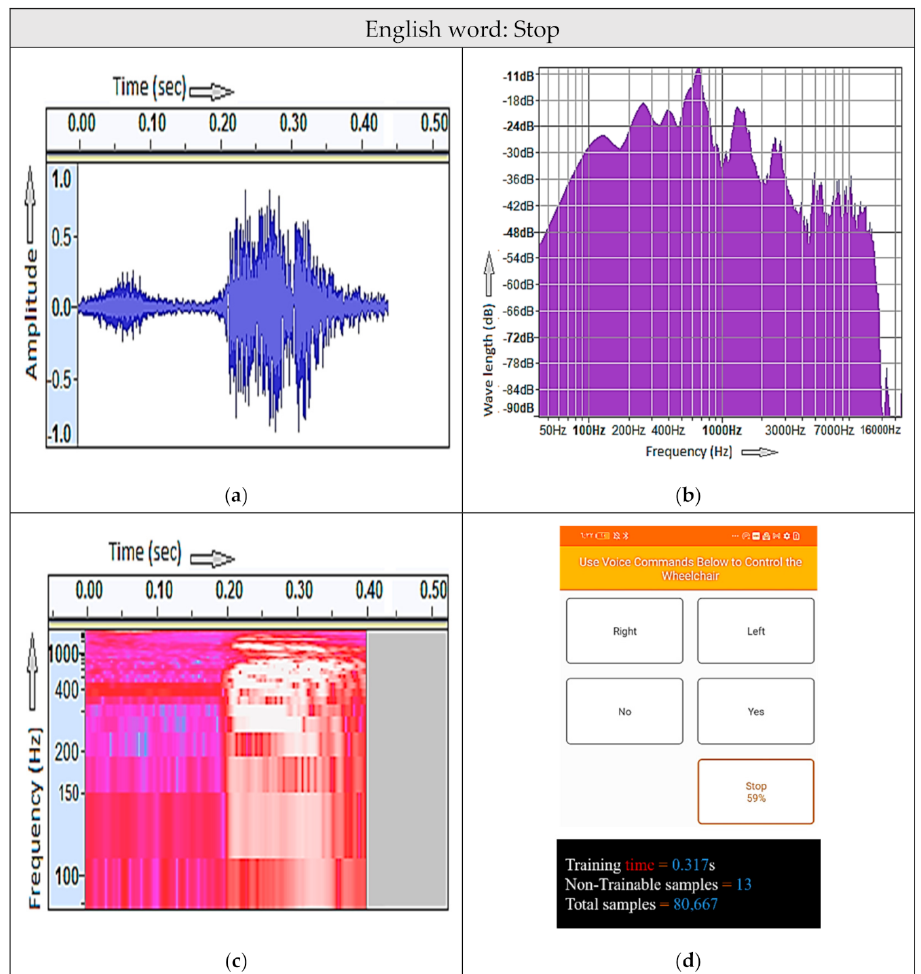
Figure 9. Recognition of the “Stop” voice command. ( a ) Audio shape; training time = 0.317 s; ( b ) long- term spectrum; frequency range = 21.26 kHz; ( c ) spectrogram; ( d ) screenshot of the mobile app.